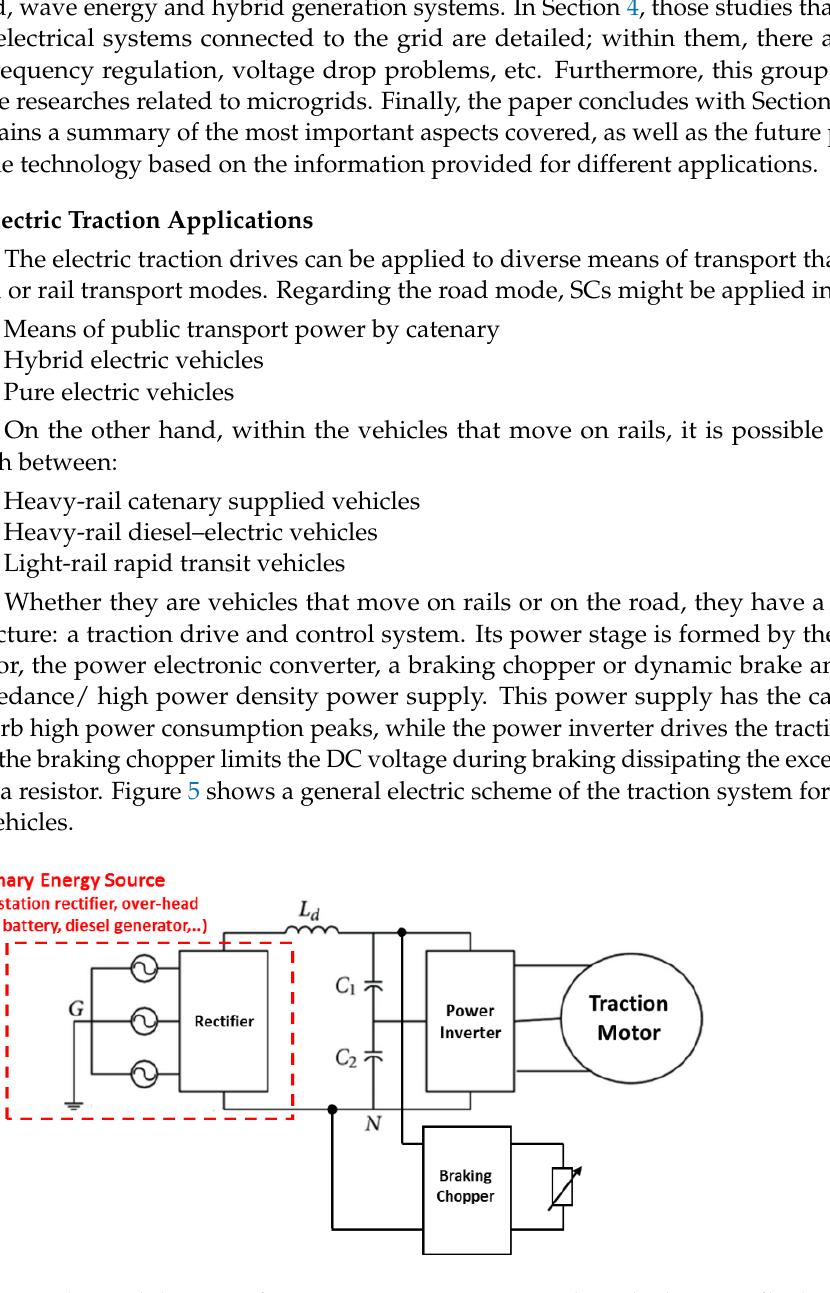
Figure 5. Electrical diagram of a traction converter connected to a high energy/high impedance power source.